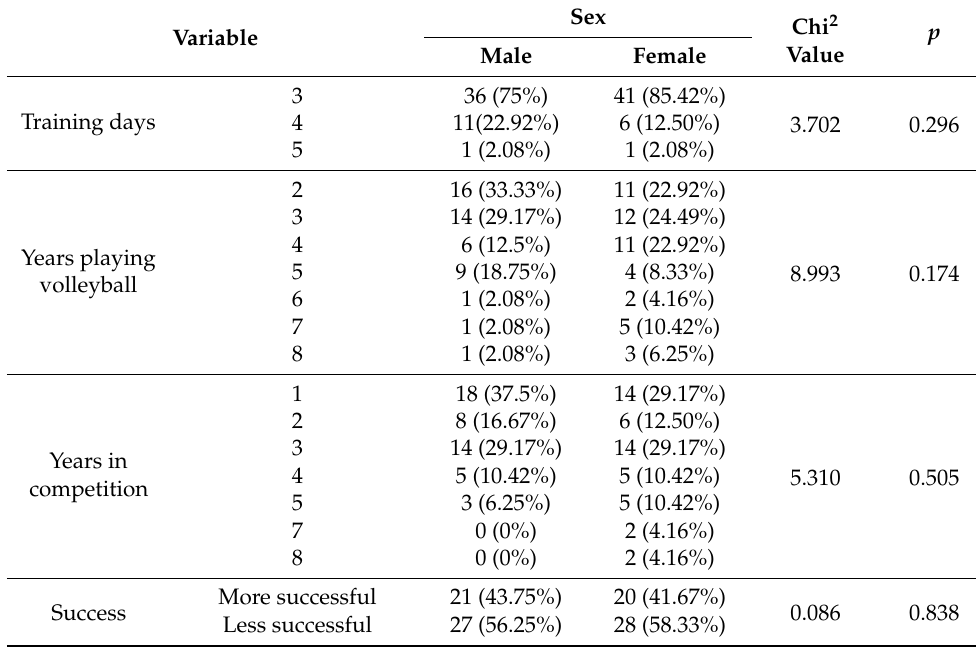
Table 5. Differences between males and females in training and selection